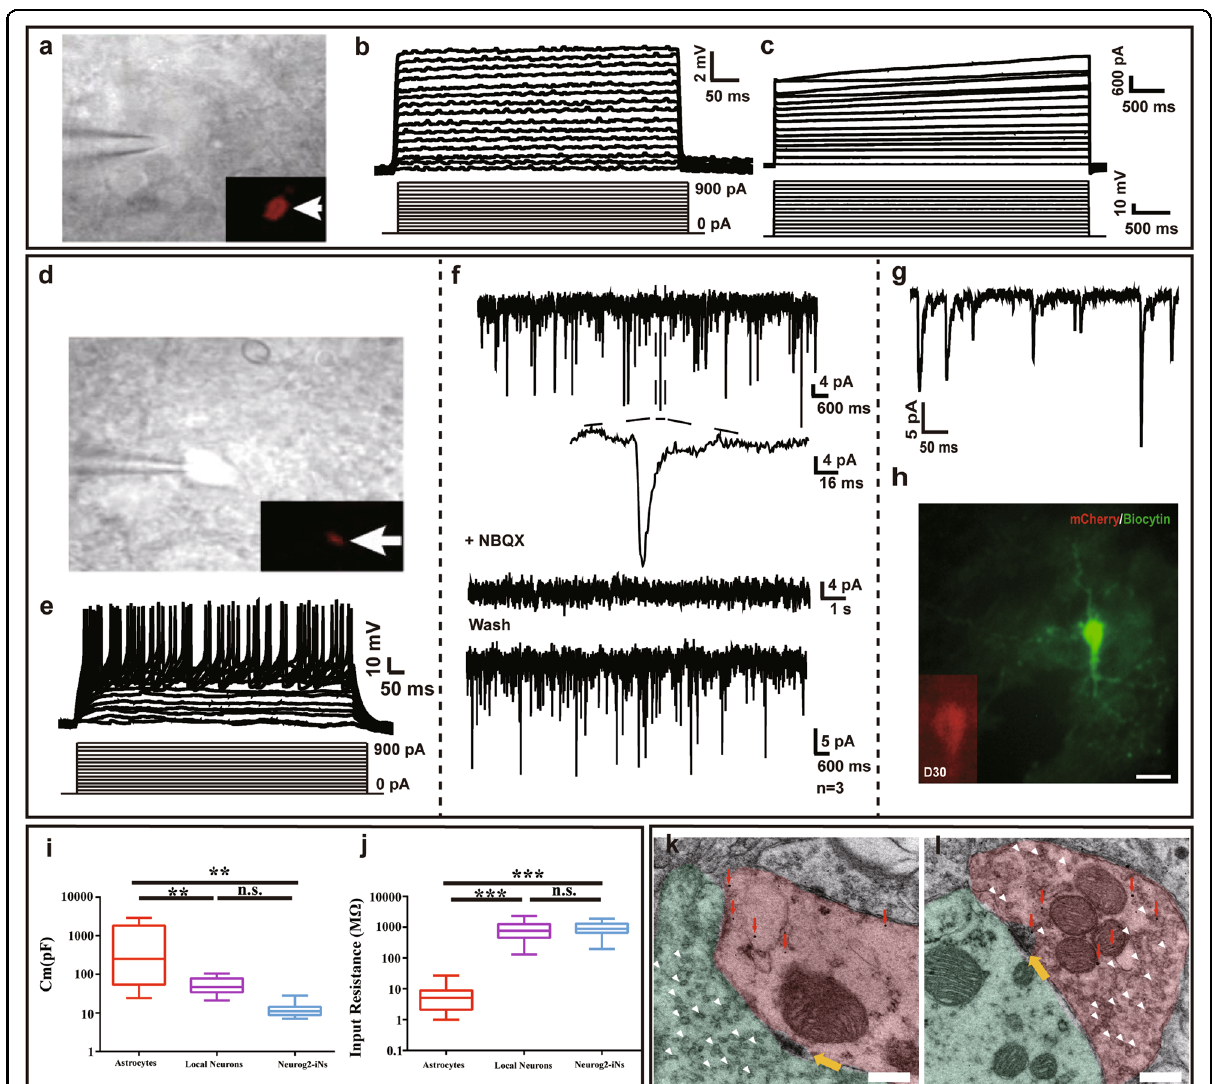
Fig. 2 iN cells are functional neurons and can form synapse with local neurons in midbrain. a – c Membrane properties of an mCherry +